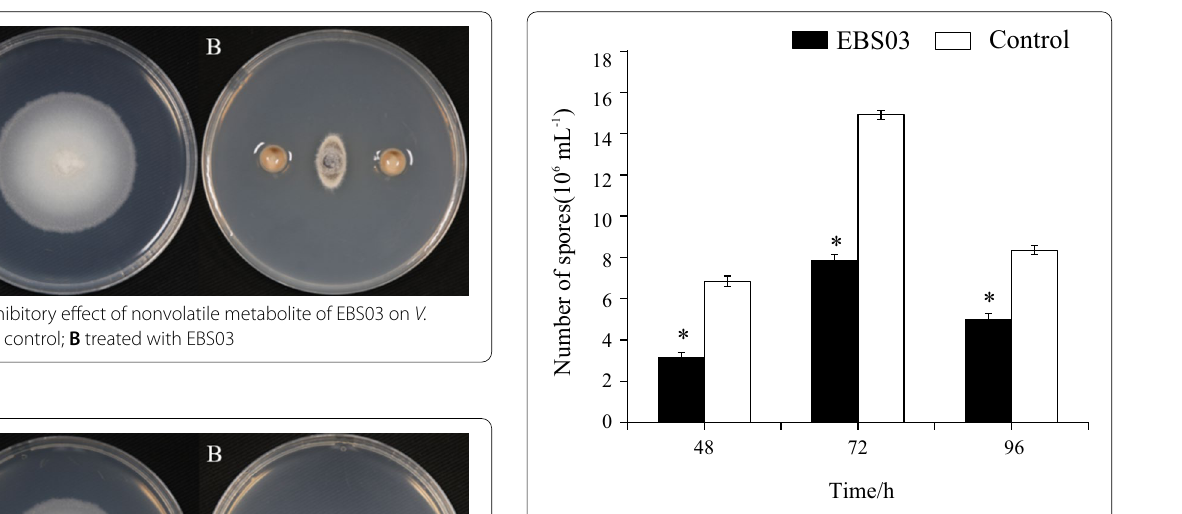
Fig. 3 Inhibitory effect of EBS03 on sporulation of V. dahliae